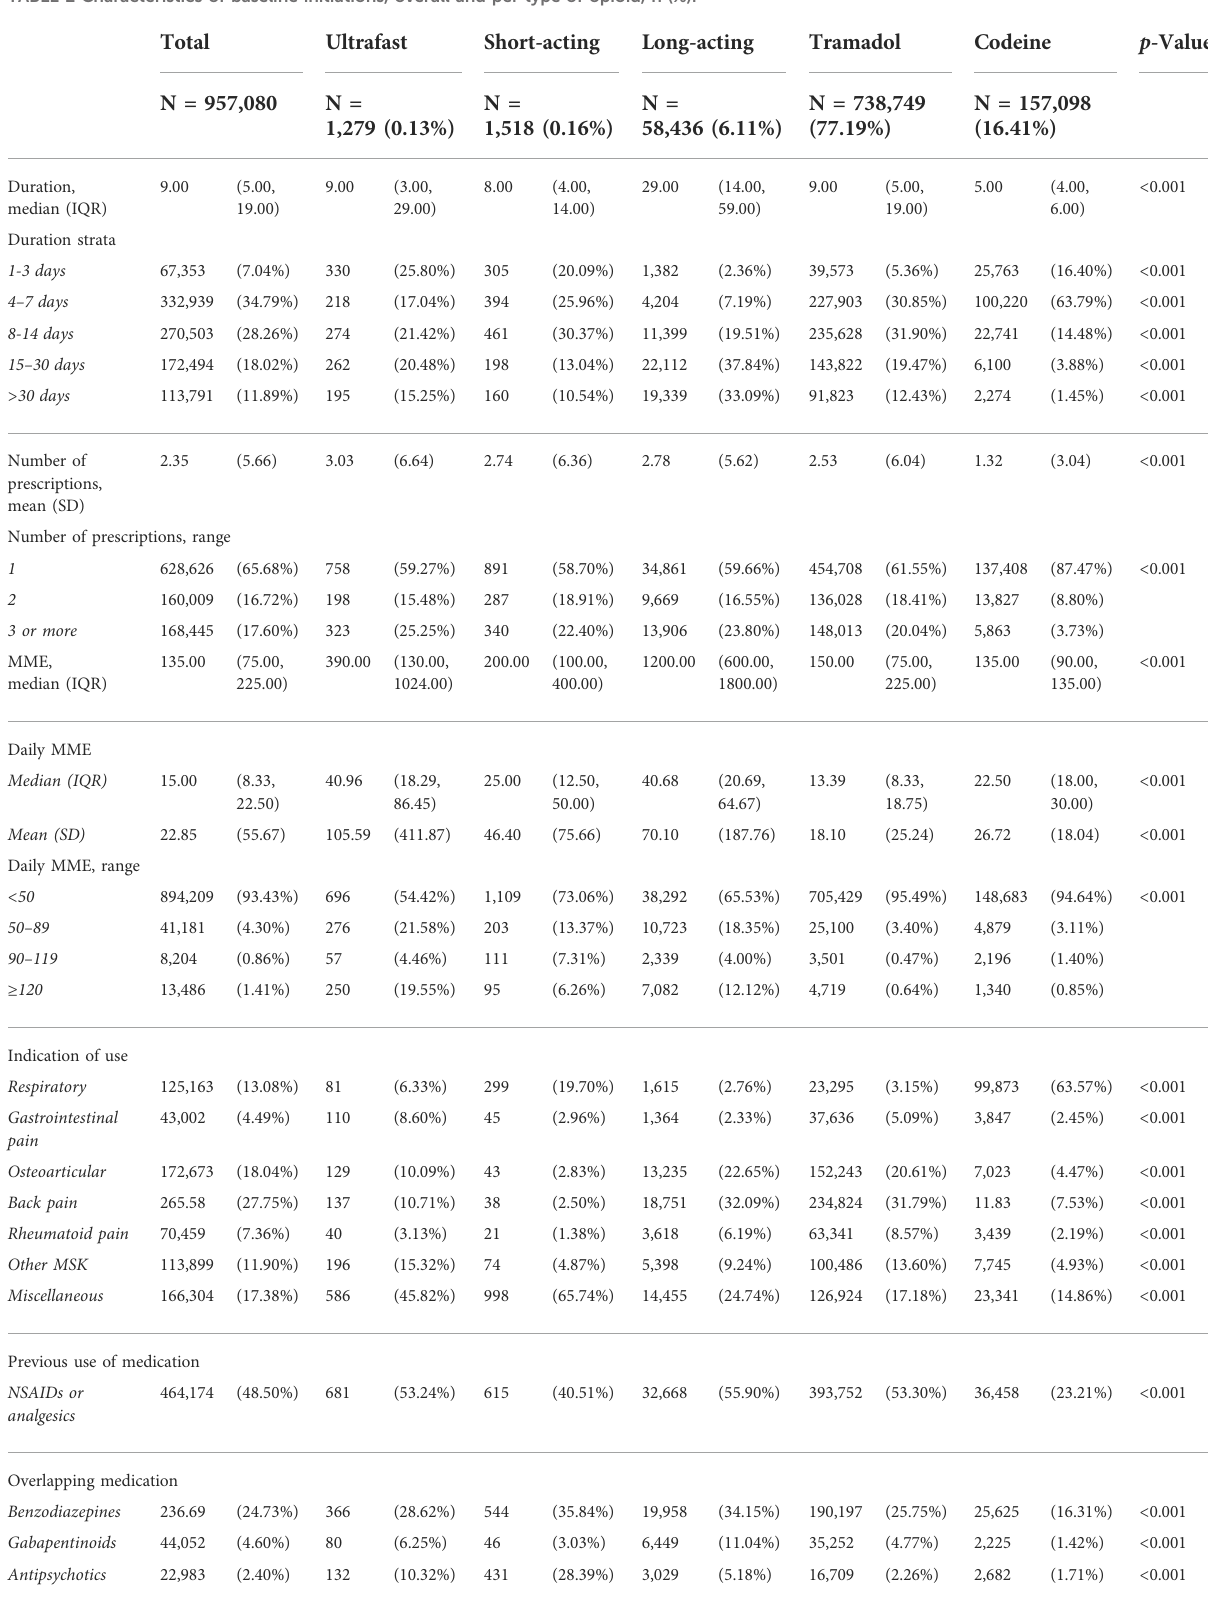
TABLE 2 Characteristics of baseline initiations, overall and per type of opioid, n